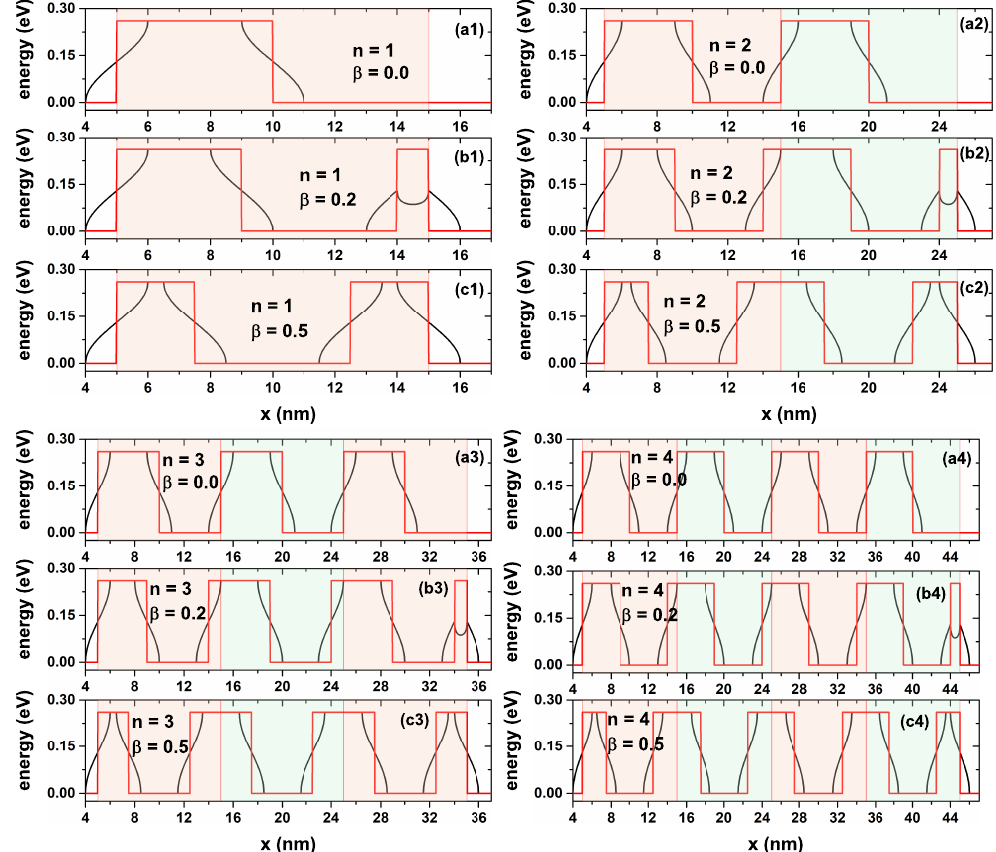
Figure 2. x -dependent potential profile of a GaAs-Al 0.3 Ga 0.7 As lattice varying from n = 1 to n = 4 periods. The shape of the periods is also modified with the β = 0.0, 0.2, and 0.5 parameters. In ( ai ), β = 0.0 and n = {1–4} for i = {1–4} respectively. In ( bi ), β = 0.2 and n = {1–4} for i = {1–4} respectively. In ( ci ), β = 0.5 and n = {1–4} for i = {1–4} respectively. The red solid lines indicate the potential with α 0 = 0, whereas the black solid line shows the potential modified with α 0 = 1.0nm. The different-color shadow regions indicate the SL periods for every